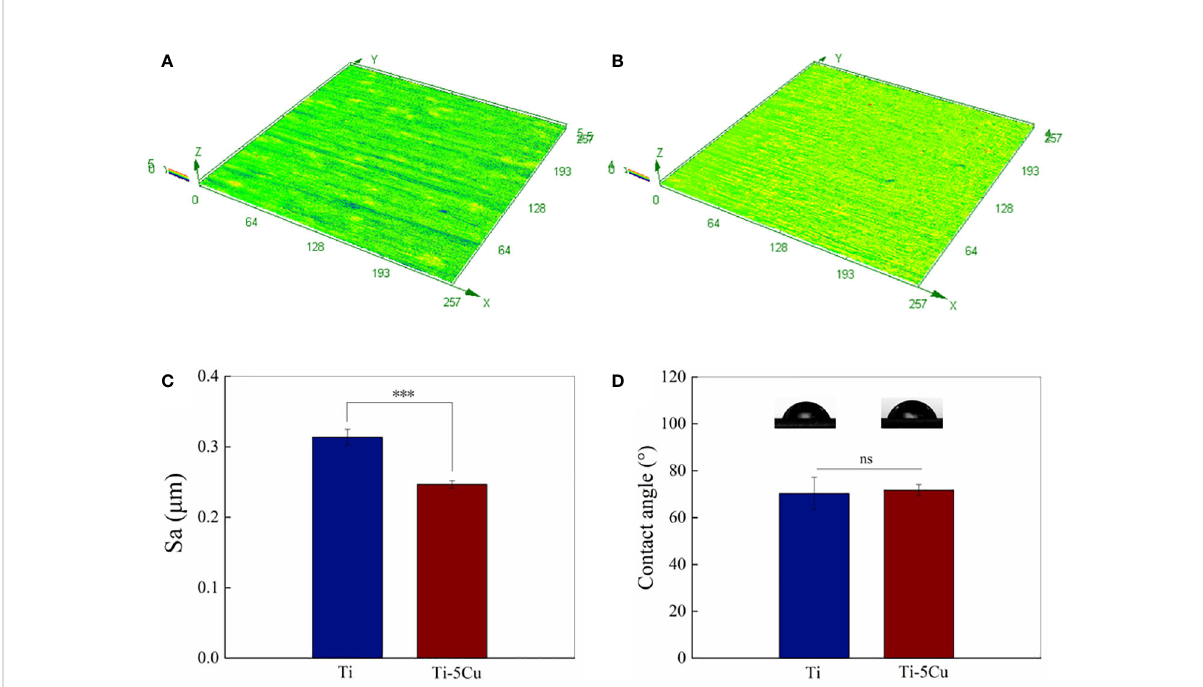
FIGURE 2 Surface roughness and hydrophilicity. (A) 3D image surface roughness of Ti; (B) 3D image surface roughness of Ti-5Cu; (C) Statistical analysis of surface roughness (Sa); (D) Contact angles of Ti and Ti-5Cu alloy (n = 4; *** p < 0.001; ns, no signi fi cant